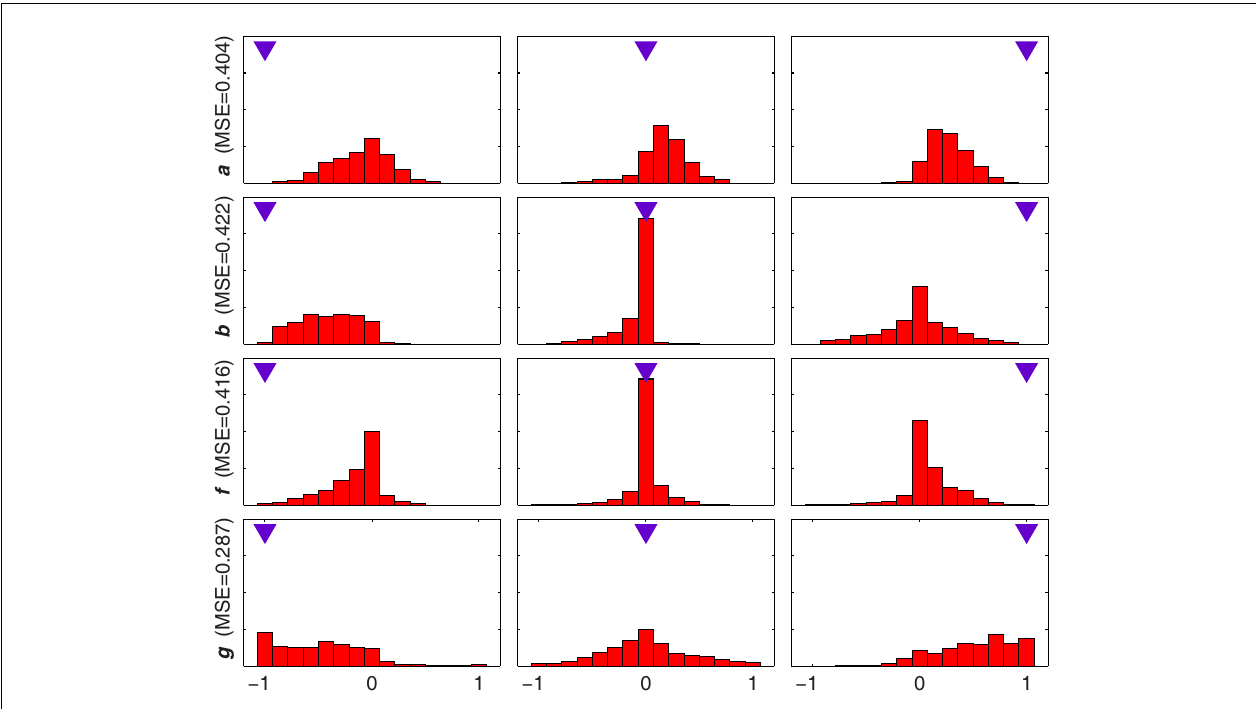
column is a histogram for those time points in which the true label is − 1, for the middle column it is 0 (no control), and for the right column it is 1.The true label is indicated by the blue